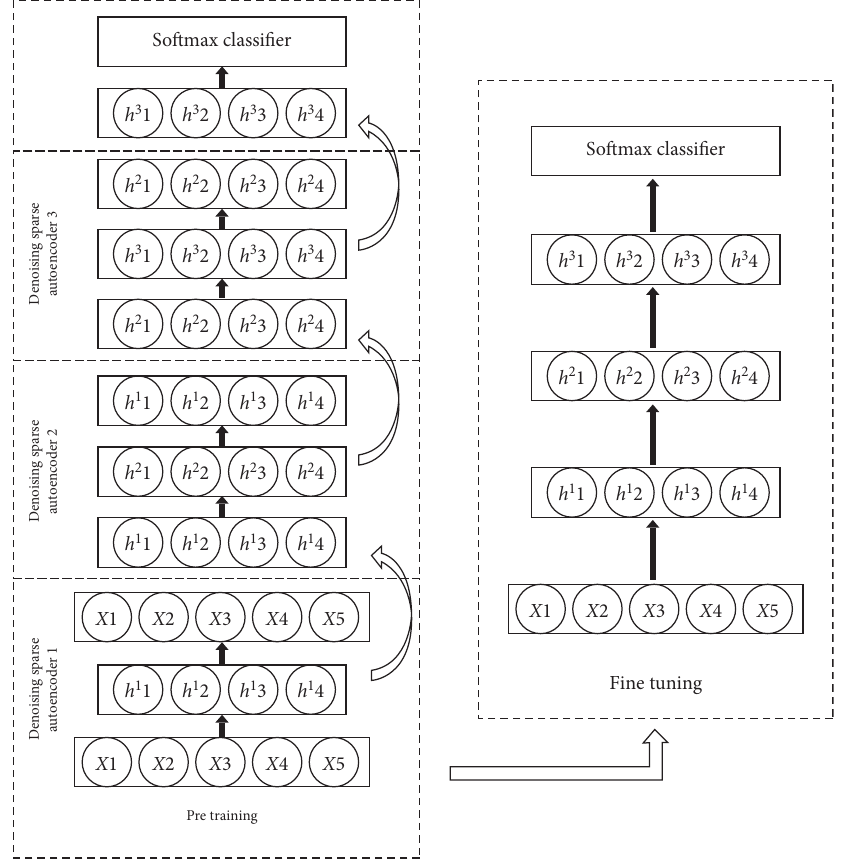
Figure 1: Training procedure of the immune-related classifier. The training of the immune-related classifier was based on stacked denoising sparse autoencoder, including two phrases, pretraining and fine-tuning. Table 3: Performance of the IRC based on